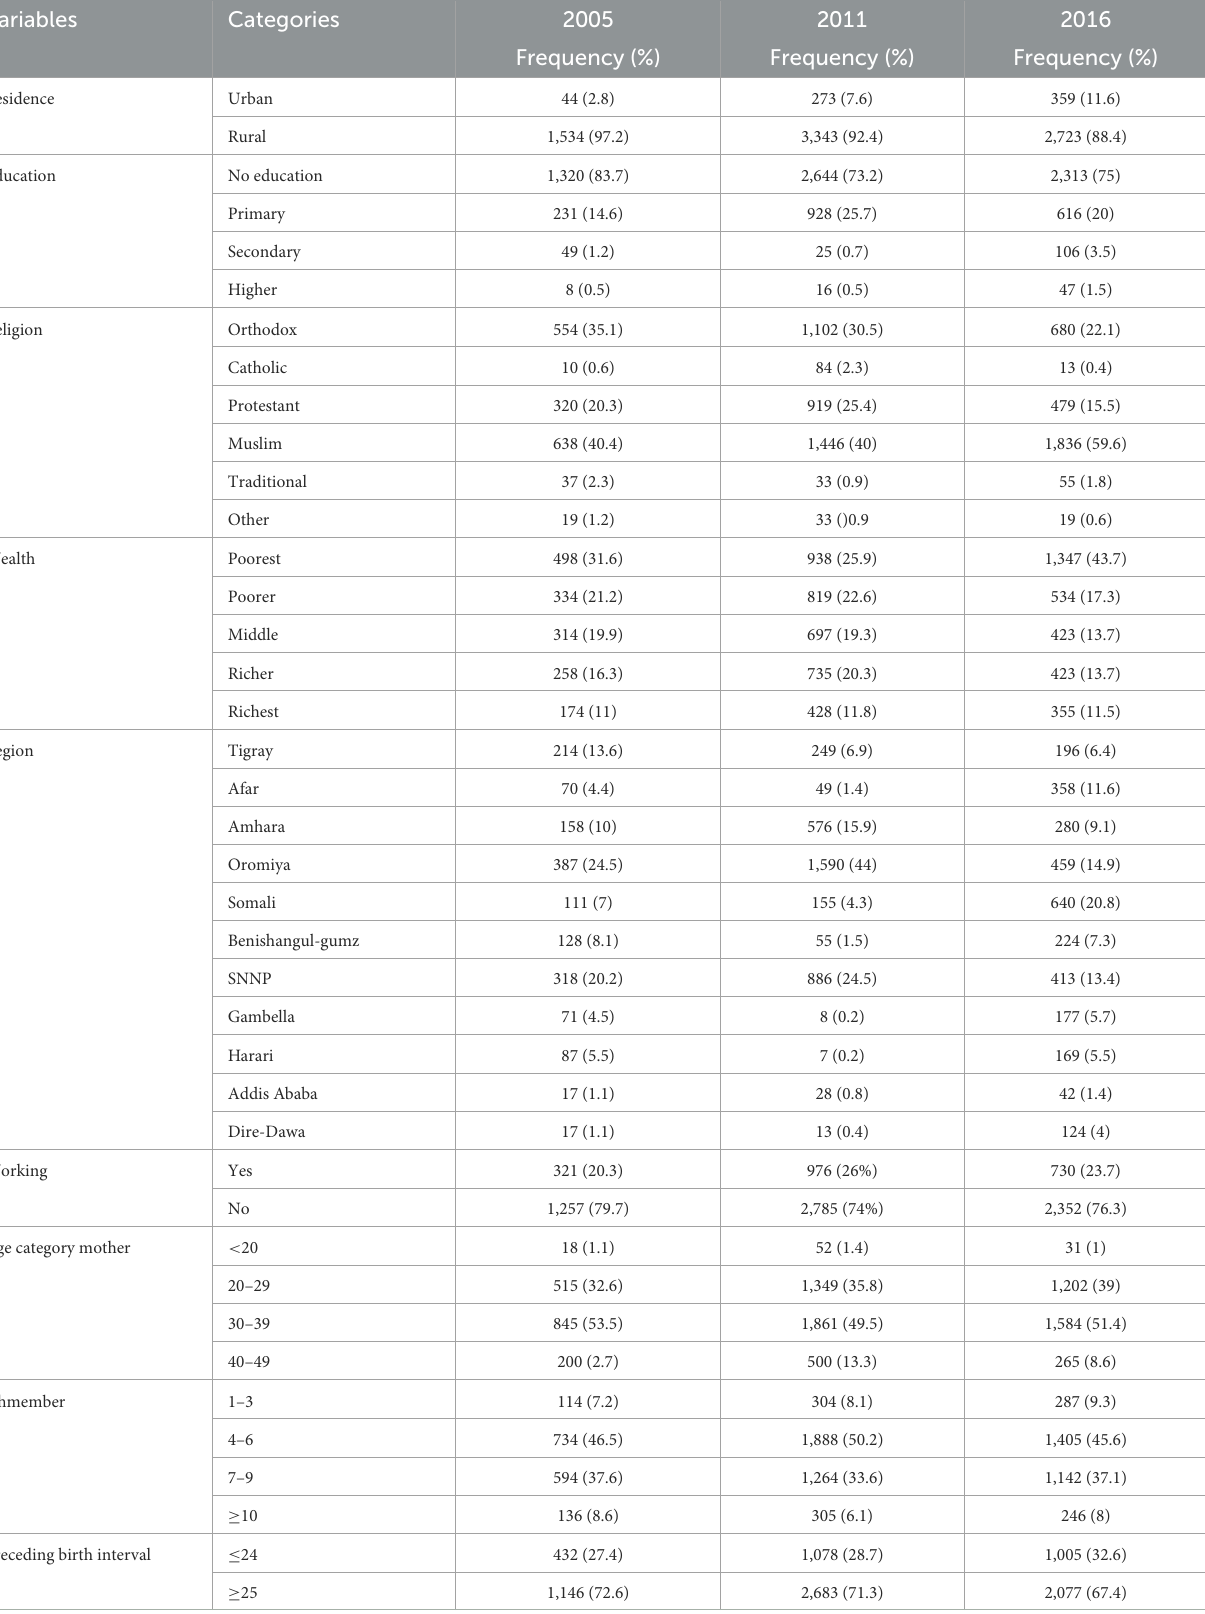
TABLE 2 Frequency distribution of independent variables among the 3 survey